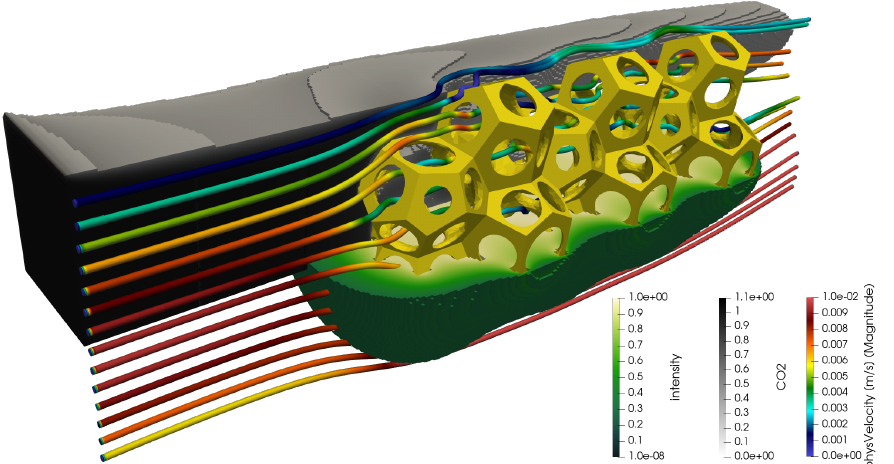
Figure 4. Coupled simulation result of flow hydrodynamics, gas transport, and light distribution in a complex PBR with internal sponge